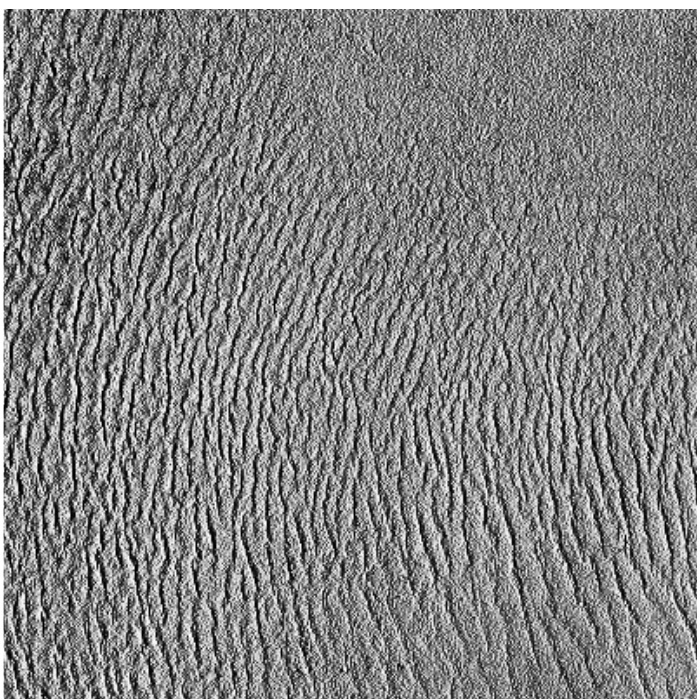
Figure 6. Example of nadir-looking Raytran surface bidirectional reflectance factor (BRF) simulation over Libya-4 for the 100 km × 100 km ROI acquired with a 250 m pixel resolution CCD camera for a sand reflectance value of 0.3. The illumination corresponds to Sun zenith angle (SZA) = 50 ◦ and Sun azimuth angle (SAA) = 270 ◦ , i.e. , from the left side. The mean reflectance of the image is 0.293 with a standard deviation of 0.024. The minimum value is 0.135 and the maximum